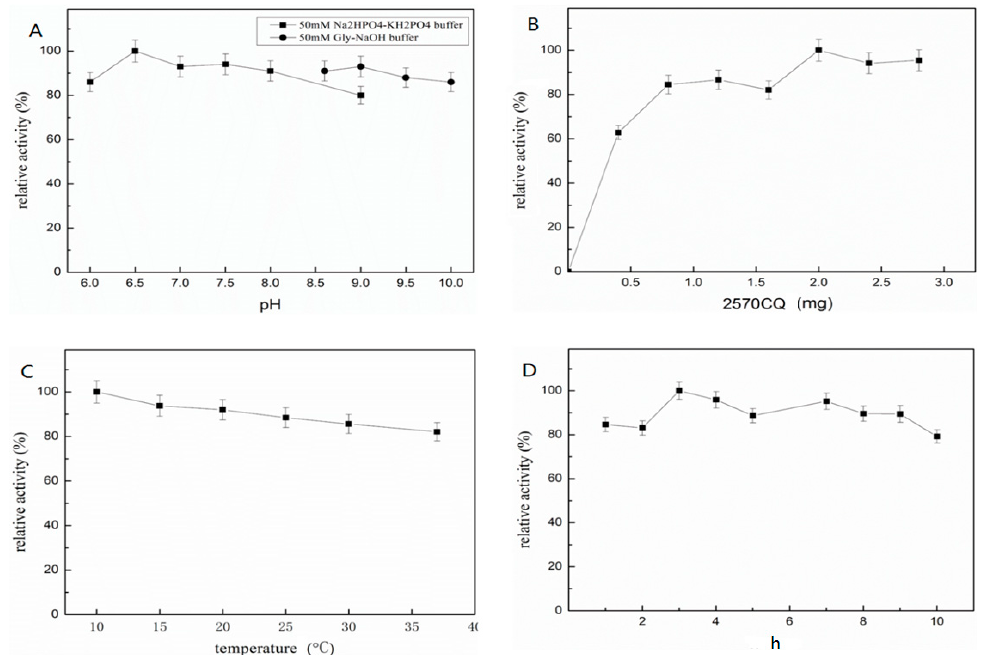
Figure 3. Conditions for the covalent immobilization of ST2570CQ on SBA-15. ( A ) The optimization of pH for the immobilization system using either, 50 mM PB buffer (pH 6.0–9.0) or 50 mM Gly-NaOH